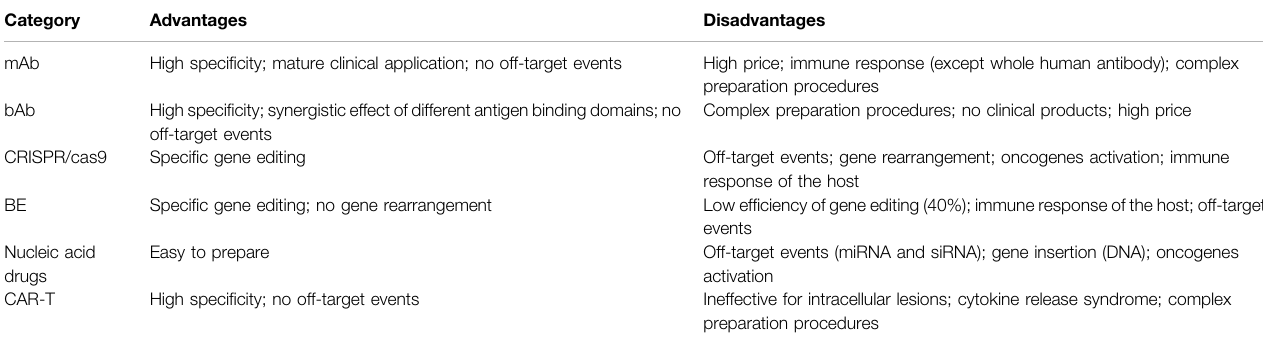
TABLE 4 | The advantages and disadvantages of the targeted